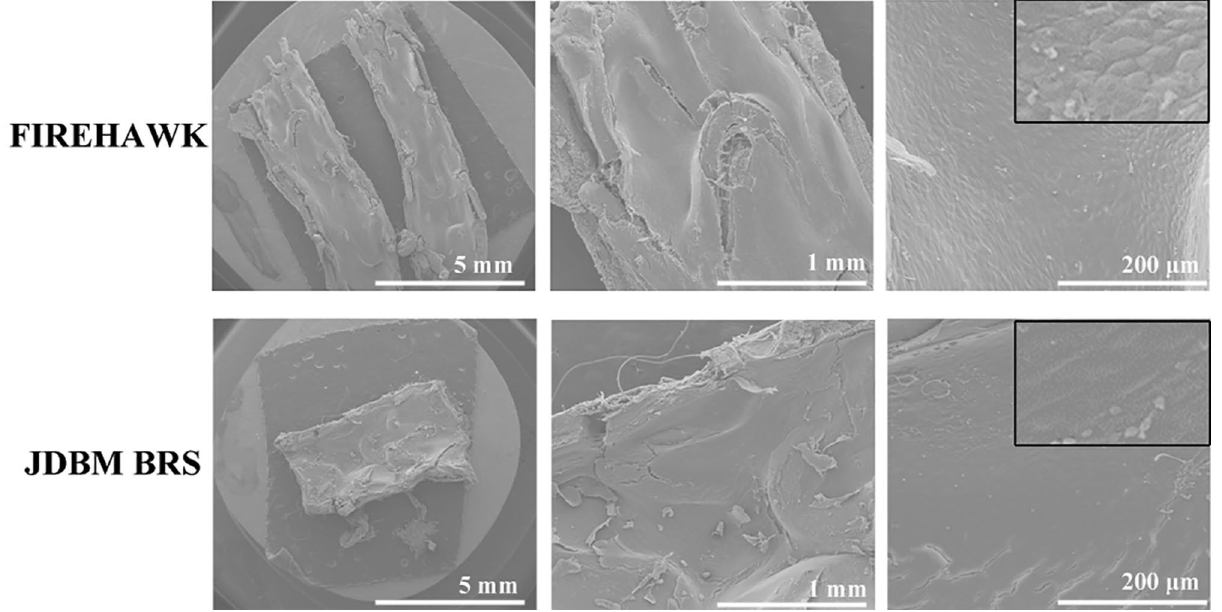
Figure 6. SEM images of JDBM BRS vs. FIREHAWK in the porcine coronary artery at 30 days post